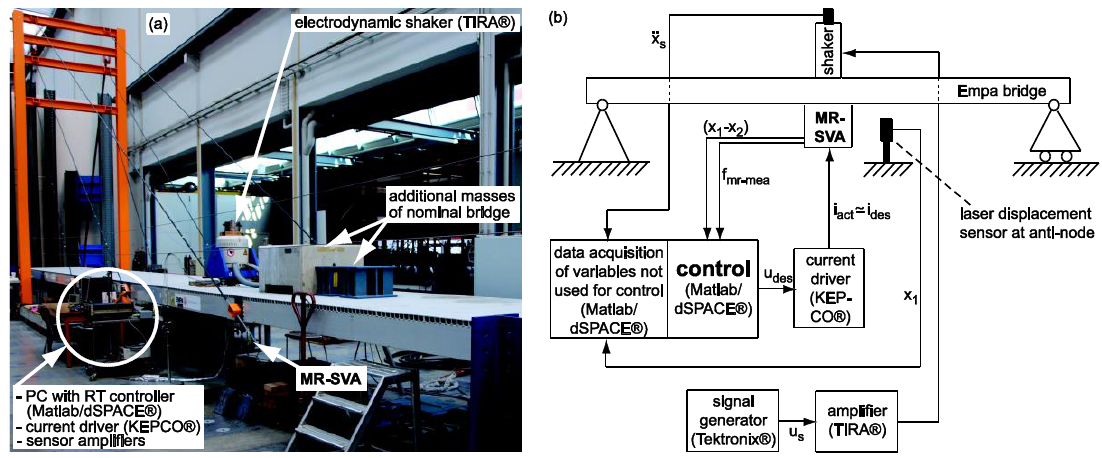
Figure 9. ( a ) Photograph and ( b ) sketch of laboratory scale bridge with prototype MR-SVA, control hardware, measurement hardware and shaker.